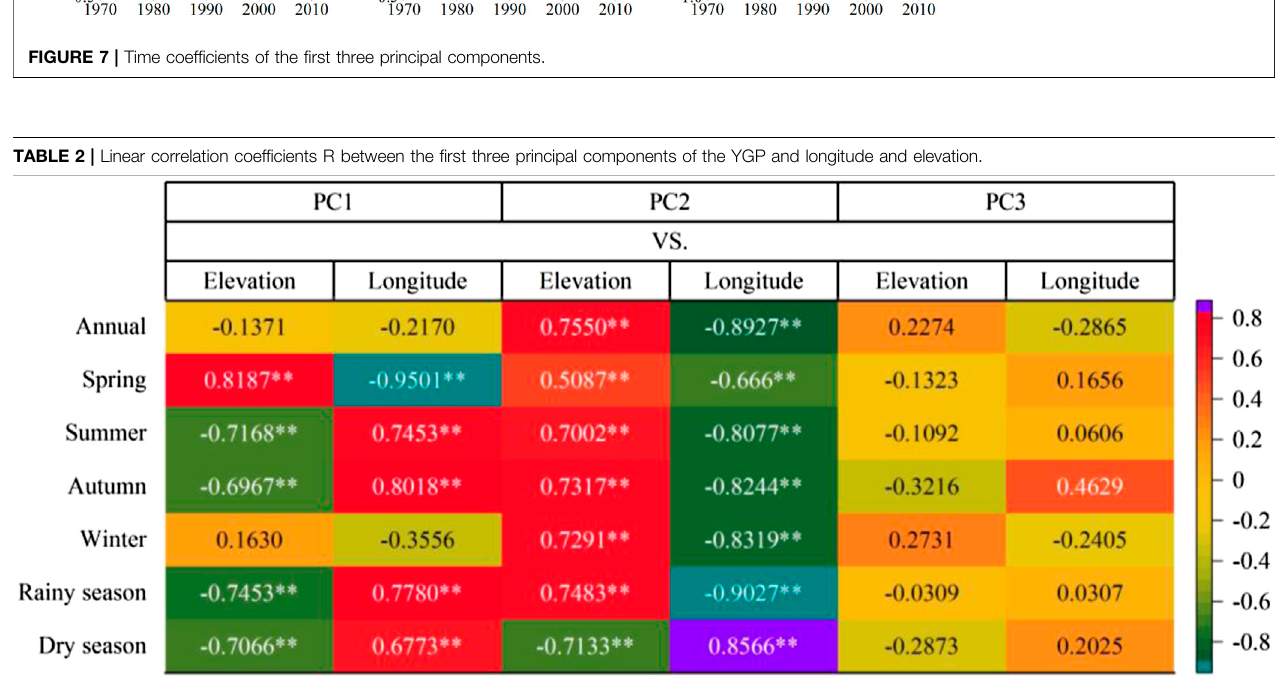
Frontiers in Environmental Science |